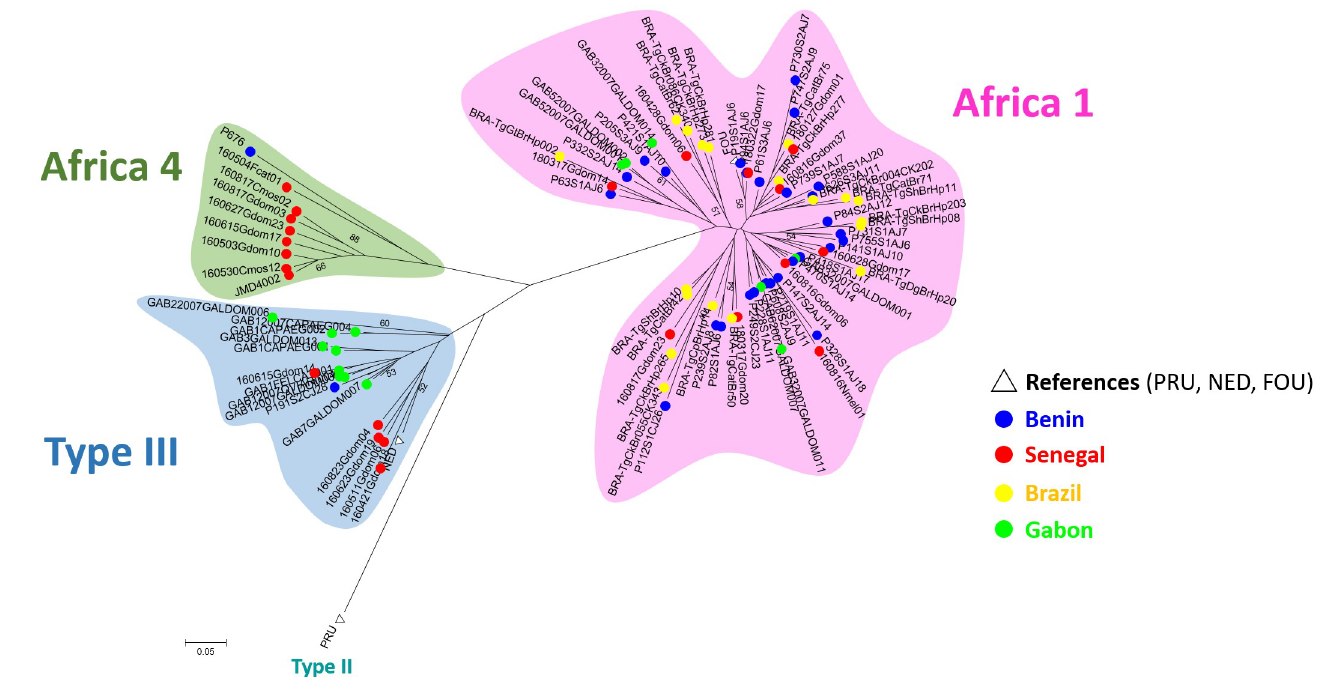
Fig 3. Global Neighbor-joining tree of genotypes inferred from calculated Cavalli-Sforza distances for 15 microsatellite markers.